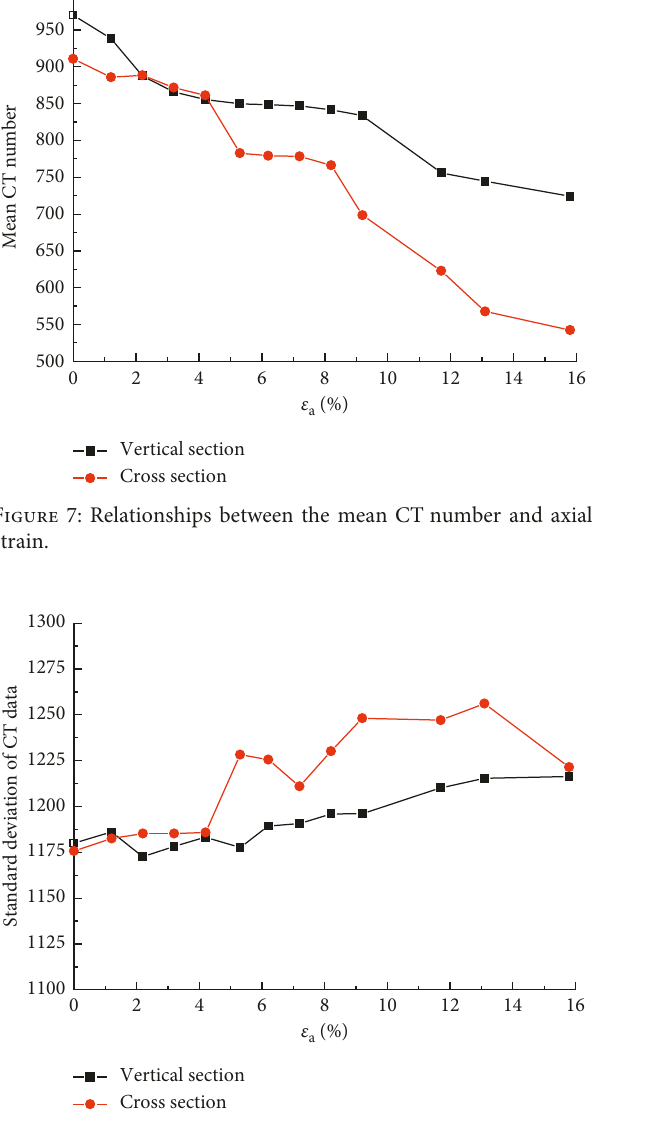
Figure 8: Relationships between the standard deviation of the CT number and axial strain.